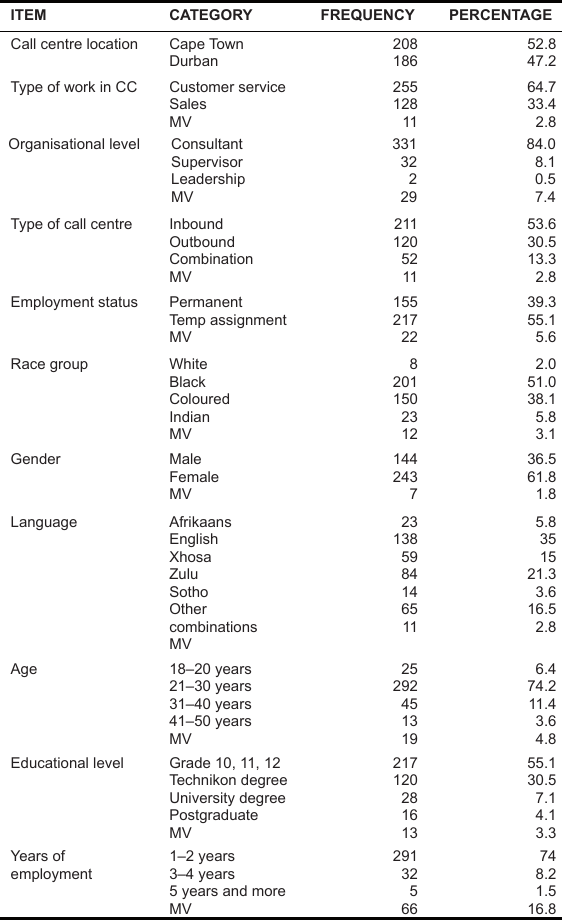
Table 2 Descriptive statistics for the densest daily